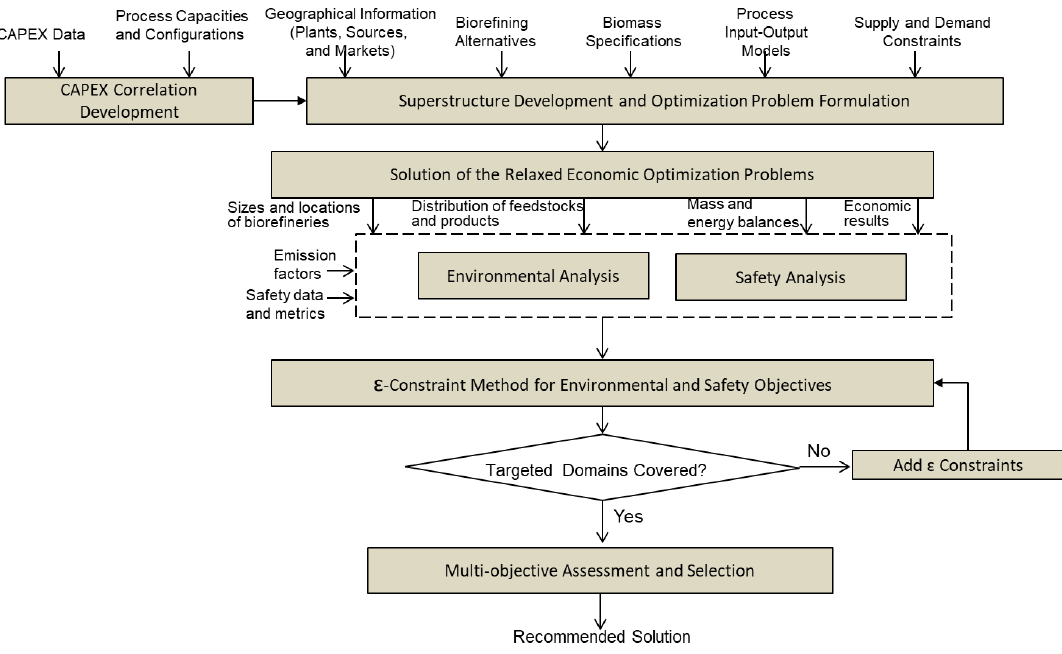
Figure 1. Flowchart summarizing the methodology.